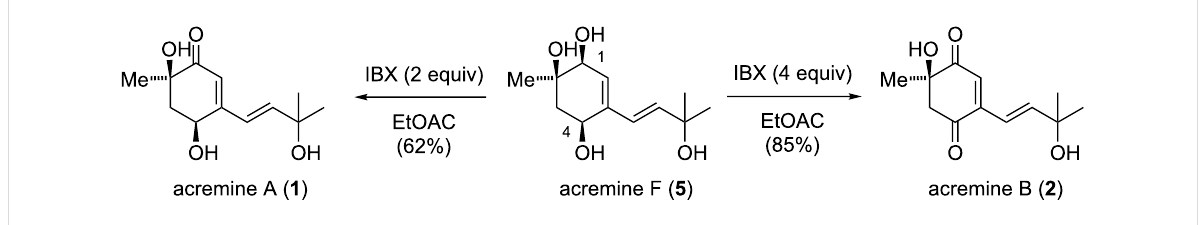
Scheme 2: Total synthesis of acremine F ( 5 ).